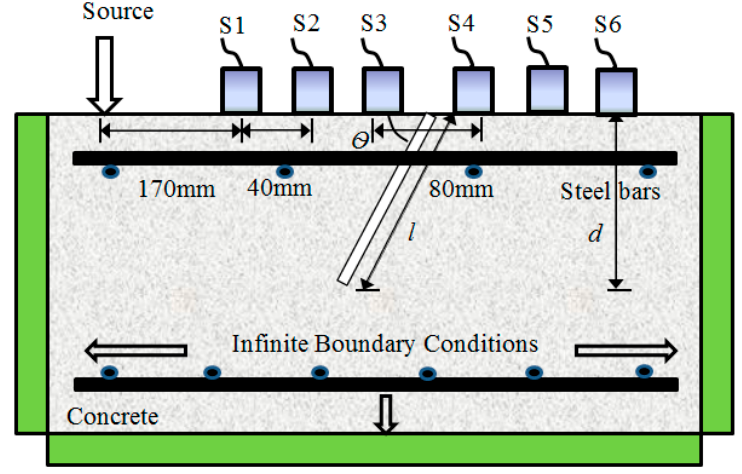
Figure 1. Schematic sketch of simulation model with inhomogeneity introduced by an inclined surface breaking crack. Table 1. Mechanical properties of the model materials obtained from experimental measurements.